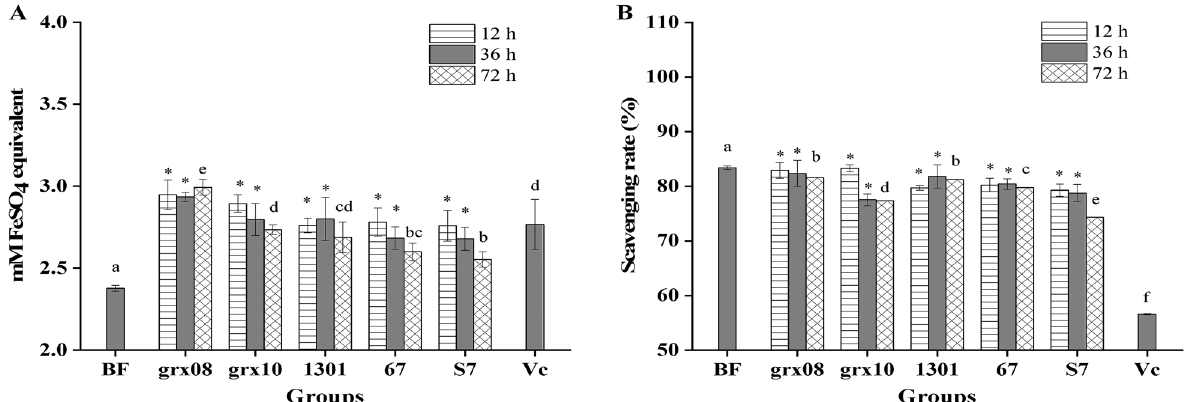
Fig. 3 Antioxidant function of different LAB before and after fermentation of FH06. A Total antioxidant capacity (FRAP value). B DPPH ability * indicates a significant difference compared with before fermentation (BF) ( P < 0.05). Different letters indicate a significant difference compared with BF and VC (0.2 mg/mL) after fermentation for 72 h ( P < 0.05)